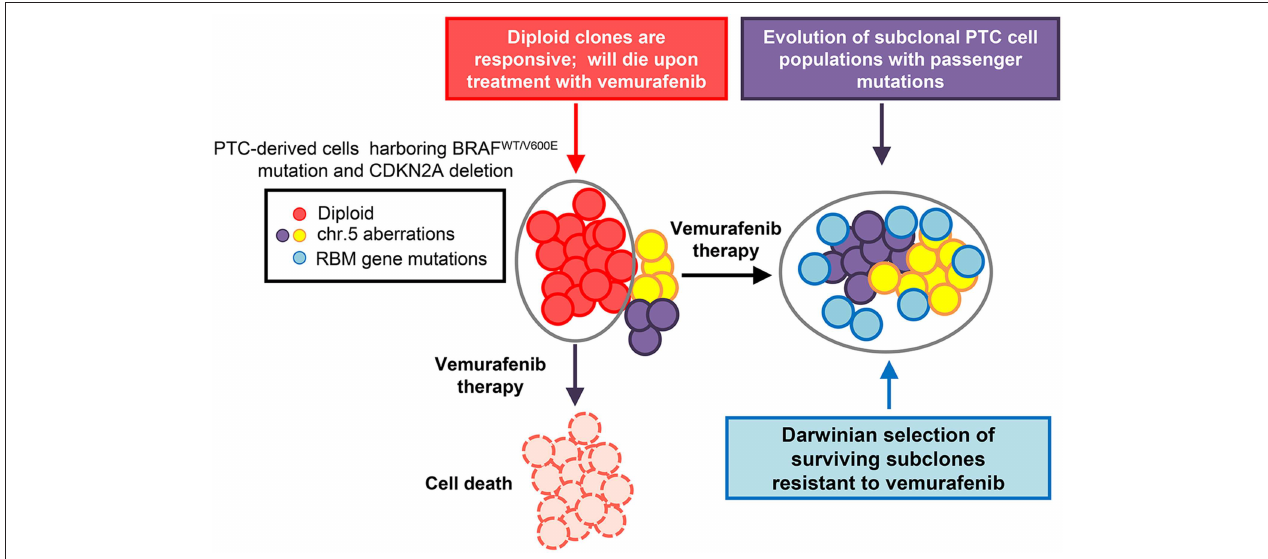
FIGURE 1 | Model of thyroid carcinoma clonal evolution. PTC-derived KTC1 cells clonally harbor the hallmark heterozygous BRAF WT / V600E mutation and show loss of the CDKN2A (P16) gene. The diploid clones compose the majority of the tumor cells genetic landscape; with there being other subclonal populations present within the overall tumor. Upon treatment with targeted therapy, in this case using the selective BRAF V600E inhibitor, vemurafenib, diploid KTC1 clones will respond positively to the drug treatment and die. However, those clones containing additional subclonal mutations, such as mutations in RBMX and RBM10 genes, or chromosome 5p amplifications, are able to overcome drug induced suppression of the BRAF V600E pathway. Through the course of vemurafenib treatment, subclones with passenger mutations, such as RBM gene family somatic mutations, can be positively selected. This tumor geography will then become enriched with populations of drug resistant mutant clones. This tumor composed primarily of vemurafenib-resistant clones, might be effectively untreatable and has the potential to lead to tumor progression.